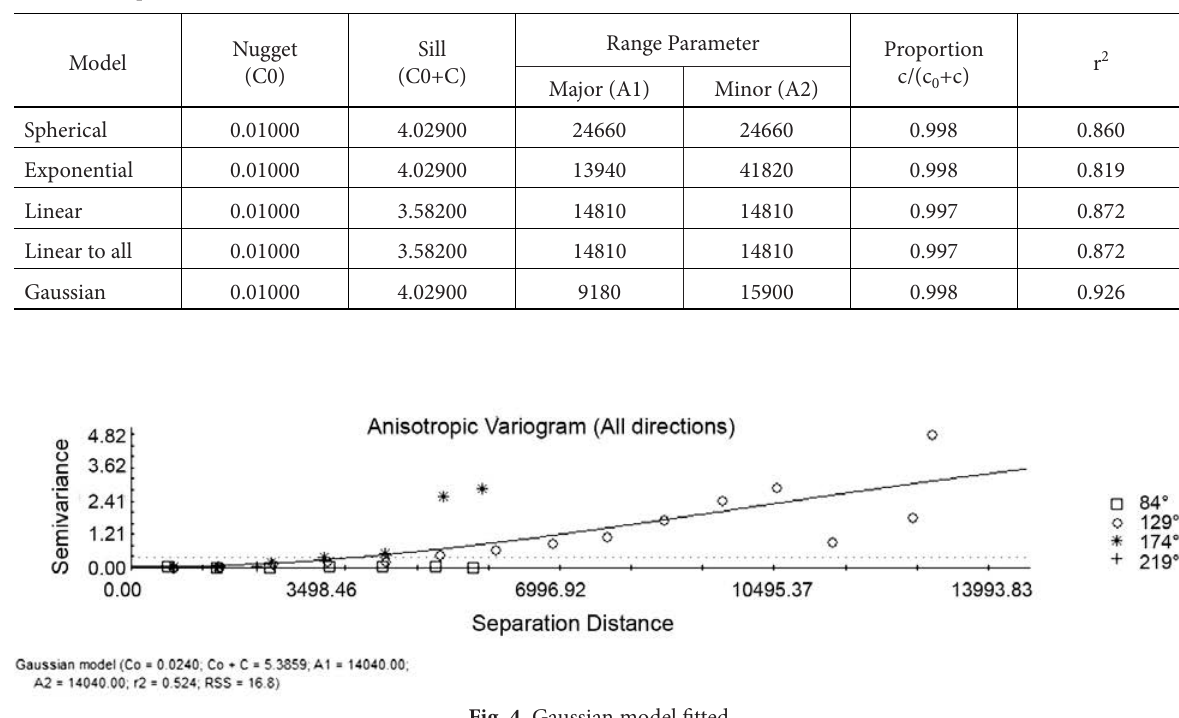
Fig. 4. Gaussian model fitted